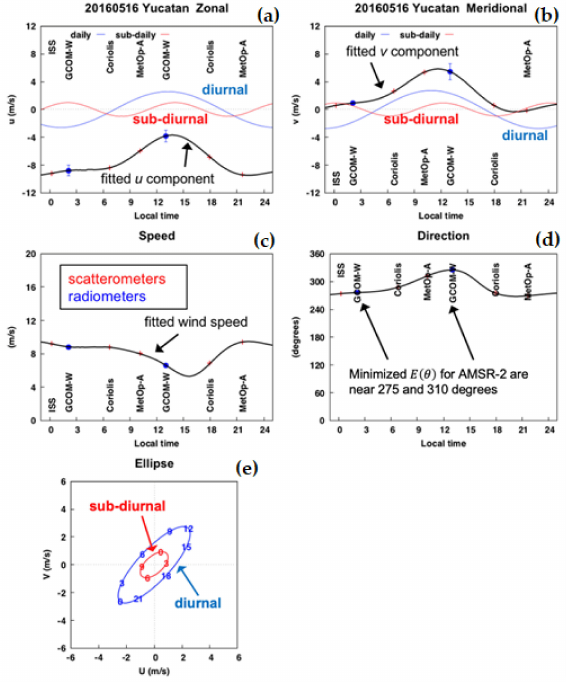
Figure 3. Diurnal wind mode analysis for one day (16 May 2016) of observations, offshore of the Yucatan peninsula. On this day, the data consisted of RapidScat, two ASCAT, two WindSat and two AMSR-2 observations ( n = 7). Each “clump” of points represents the collection of 25-km wind vector cells that falls into this region. ( a , b ) The estimated diurnal and semidiurnal (u , v) wind components in blue and red, respectively, and the “fitted” ( u , v ) components. ( c , d ) Same data as in the top panels, but shown in speed and direction ( w , θ ) coordinates. ( e ) Wind ellipses formed by the (mean-subtracted) diurnal and semidiurnal wind components. Both the diurnal (blue) and a smaller semidiurnal (red) wind ellipse spin clockwise with magnitudes < 3 m s − 1 .